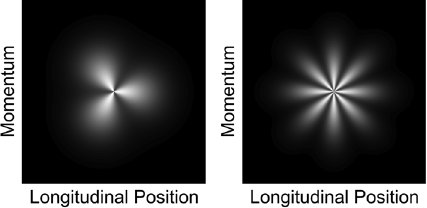
FIG. 1. Models of the phase space densities for modes m ¼ 3 (left) and m ¼ 8 (right) assuming a cos ð m φ Þ azimuthal distortion with a Gaussian radial dependence. The patterns rotate at the synchrotron frequency F and the mode frequencies are mF syn syn